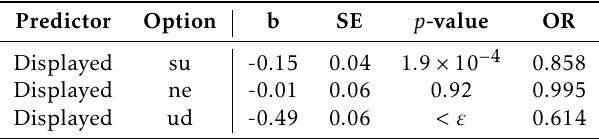
Table 3. Results of the multinomial logistic